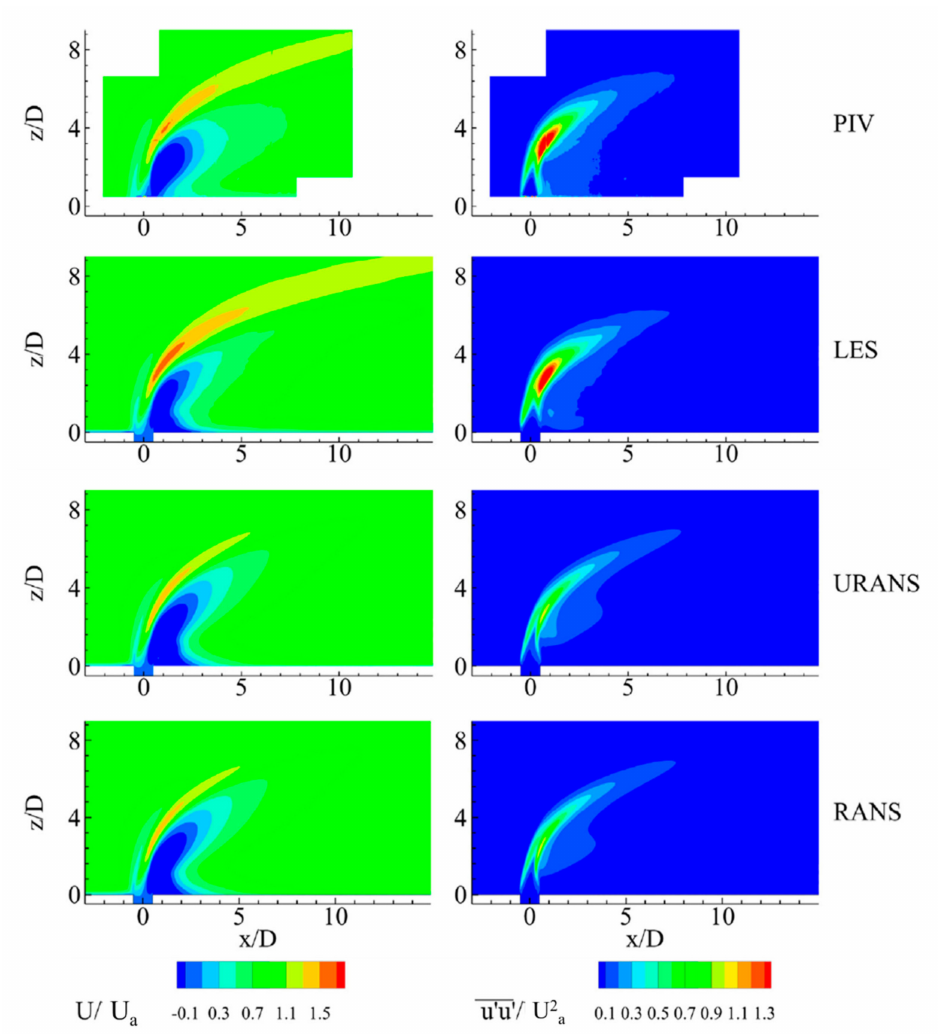
Figure 21. Two–dimensional maps of mean velocity component ( U / U a ) and specific Reynolds stress component ( u (cid:48) u (cid:48) / U 2 a ) at the symmetry plane [126].